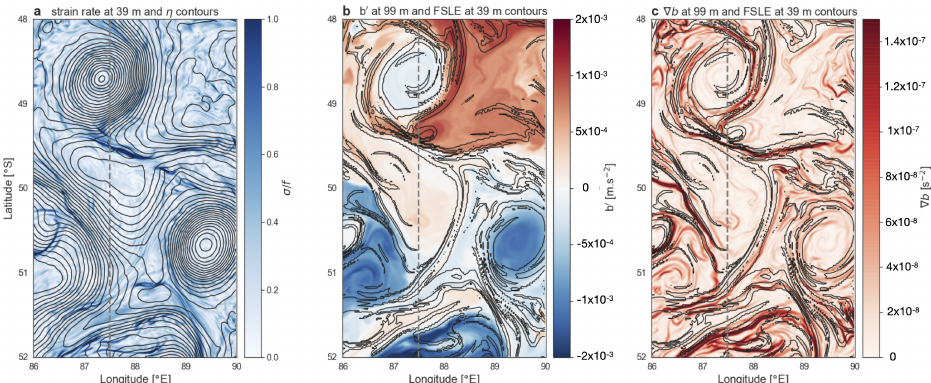
Figure 1. Map of ( a ) strain rate σ normalized by f at 39 m superimposed with contours of η ranging from − 1.85 to − 0.85 m at 0.03 m interval. ( b ) Buoyancy anomaly b’, defined as the anomaly with respect to the domain-averaged value, at 99 m superimposed with contours of finite-size Lyapunov exponent (FSLE) at 39 m ranging from − 2.25 to − 0.4 day − 1 at 0.5 day − 1 interval. ( c ) Buoyancy gradients |∇ b | at 99 m superimposed with the same FSLE contours as in ( b ). The dashed gray line at 87.5 o E corresponds to the section in Figure 2. Randomly selected snapshot on 27 October 2011 00:00:00 UTC.